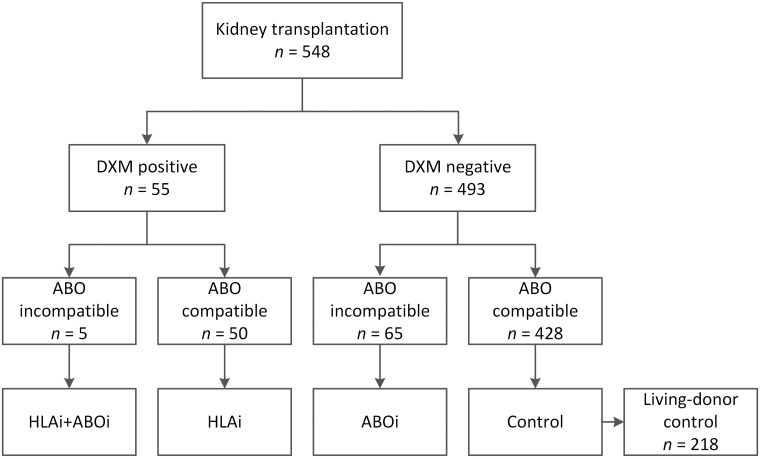
Baseline patient distribution according to ABO and immunological matches.Abbreviations: ABOi, ABO incompatible; DXM, direct cross-match; HLAi, HLA incompatible; LD, living-donor.